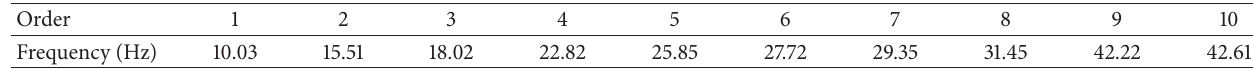
Table 2: Top 10 natural frequencies.